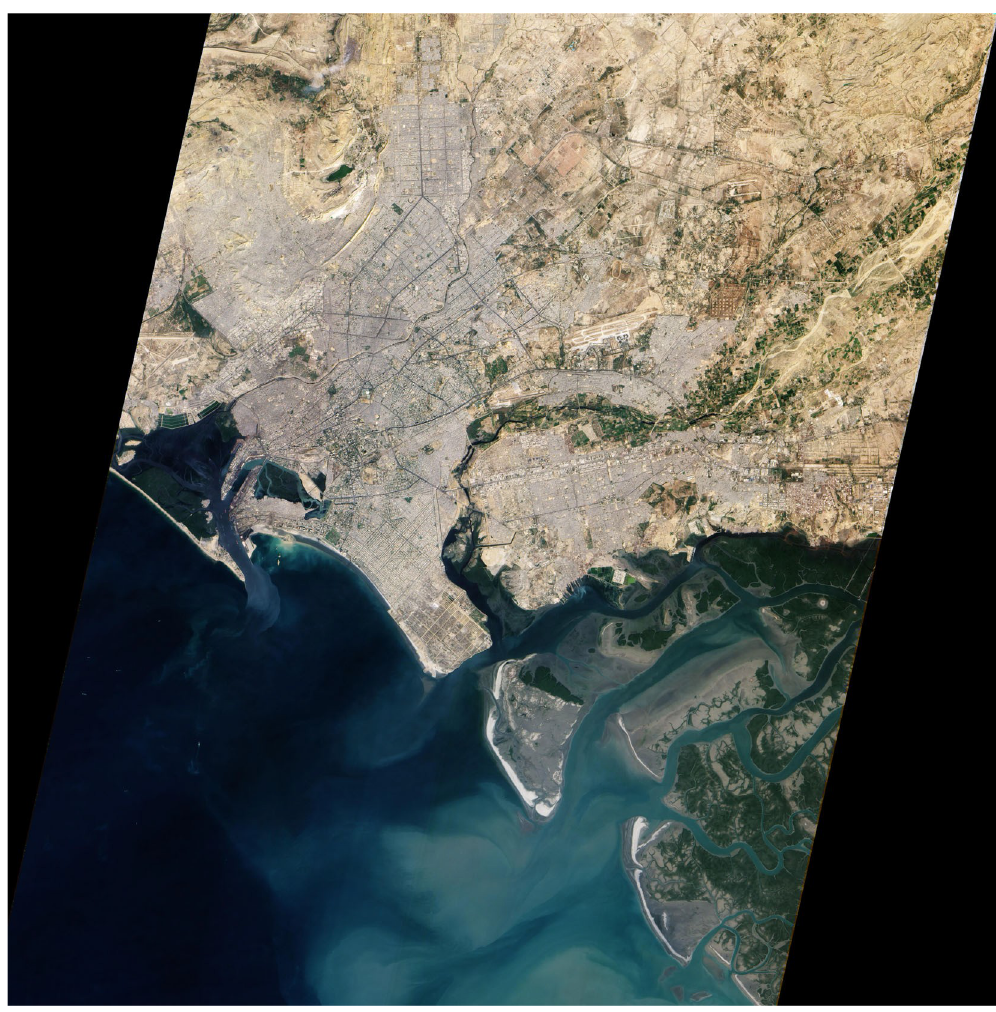
Fig 1. Satellite view of Karachi. Image adapted from http://earthobservatory.nasa.gov/IOTD/view.php?id=42538.